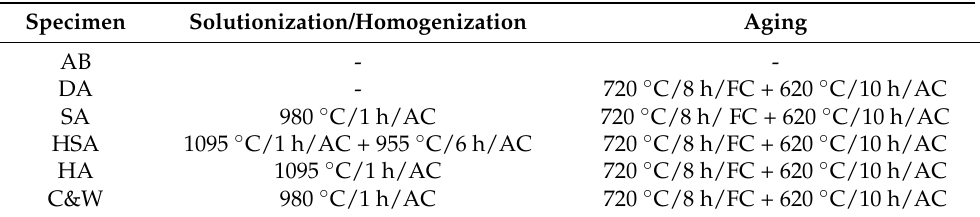
Table 2. Details of the heat-treatment conditions for the EBM IN718 and corresponding nomenclature.